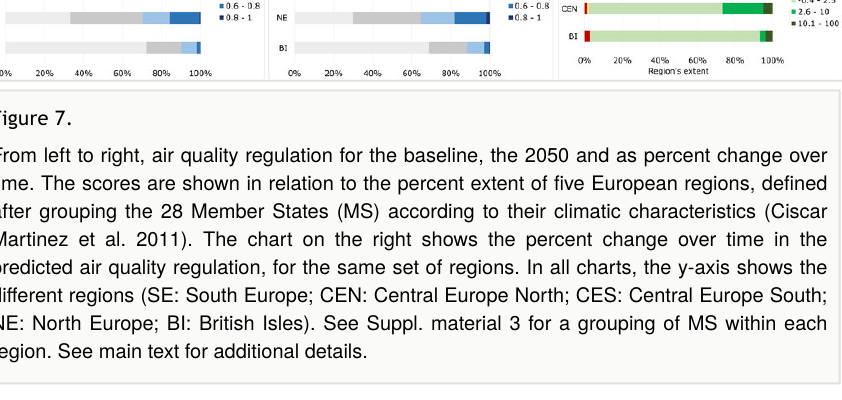
Fig. 8 shows soil erosion control resulting from the BN models over LULC types. Soil erosion control is displayed as a relative index between 0 and 0.9 for the baseline and the 2050, and as a percent change between 2050 and the baseline. The index for erosion control had mean = 0.32 and SD = 0.26 for the baseline, and mean = 0.34 and SD = 0.27 for 2050.